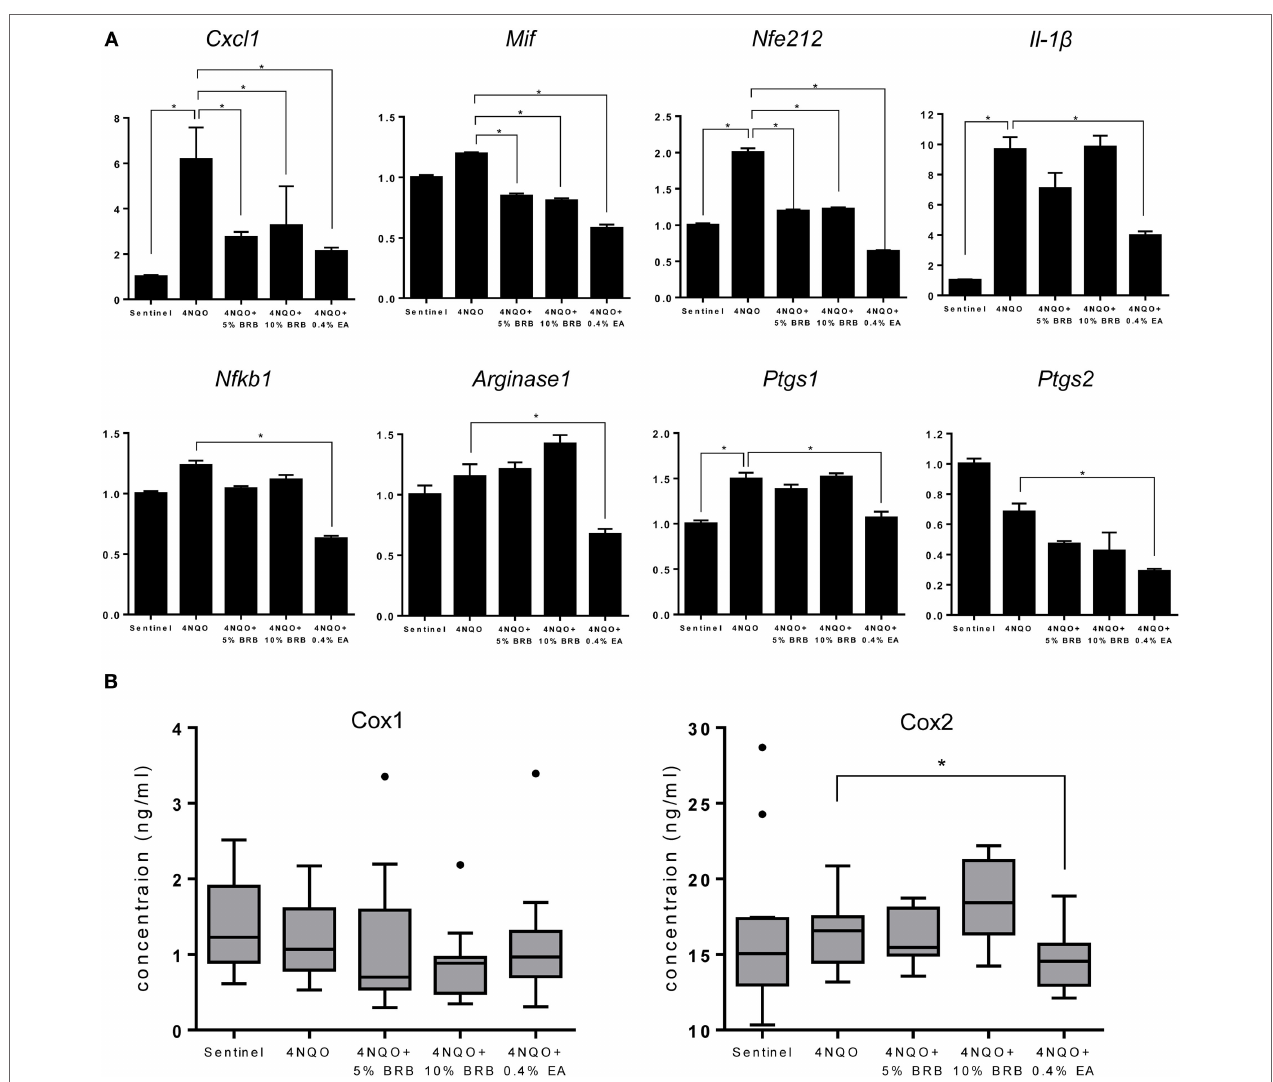
FigUre 4 | (a) Gene expression profiles of the pro-inflammatory markers Cxcl1, Mif, Nfe212, Il-1 β , Nfkb1, Arg1, Ptgs1 , and Ptgs2 during 4-nitroquinoline 1-oxide (4NQO)-induced oral carcinogenesis determined by reverse transcription quantitative PCR. Data are presented as mean fold induction over sentinels ± SE. * p -value < 0.05 for each group ( N ≥ 20) comparison using analysis of variance analysis. (B) Serum concentrations of cyclooxygenase 1 (Cox-1) and Cox-2 in randomly selected rats from each experimental group ( N = 15) during 4NQO-induced oral carcinogenesis as determined by enzyme-linked immunosorbent assay. Data are presented as mean ± SE. * p -value < 0.05 for each respective group comparison using independent Student’s t